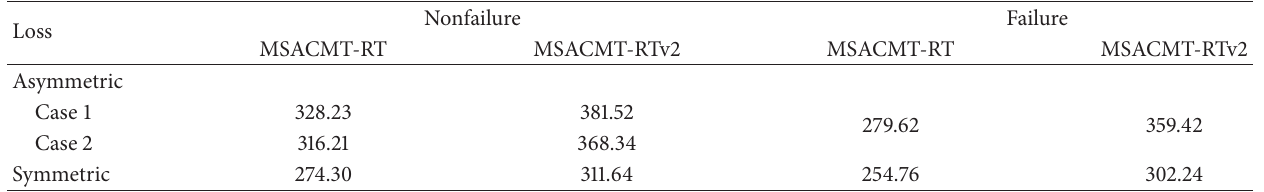
Table 6: Asymmetric path delays—average throughput in